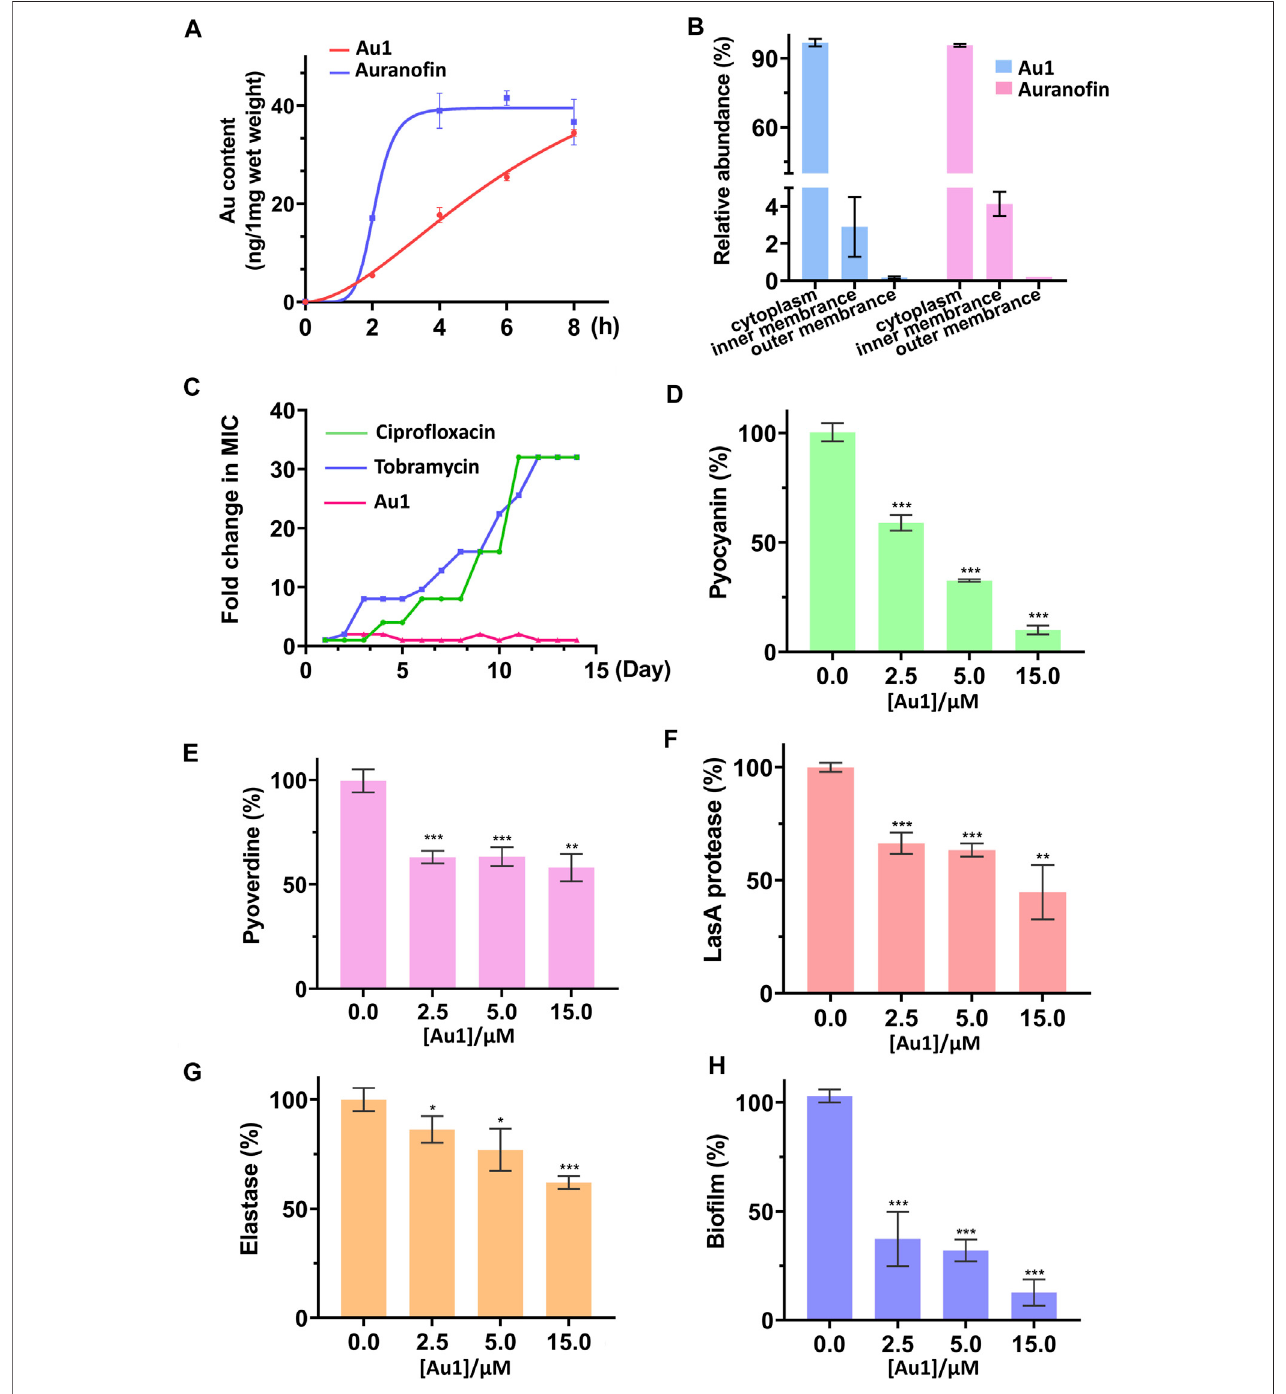
FIGURE 2 | (A) Kinetics of Au1 and aurano fi n uptake by P. aeruginosa . (B) Subcellular distribution of Au contents in bacteria after Au1 or aurano fi n treatment (C) Bacterial resistance studies of Au1, cipro fl oxacin and tobramycin clinical against P. aeruginosa . The inhibition of bacterial pyocyanin (D) , pyoverdine (E) , LasA protease (F) ,elastase (G) andbio fi lmformation (H) byAu1compoundwithdifferentconcentrations.Allexperimentsareperformedintriplicatedanddataarepresentedasmean± sd. * means p < 0.05, ** means p < 0.01, *** means p < 0.001.